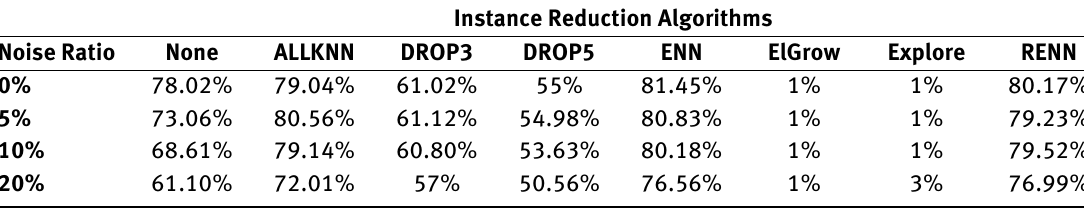
Table 9: Average classification accuracy for unpruned trees at different noise ratios